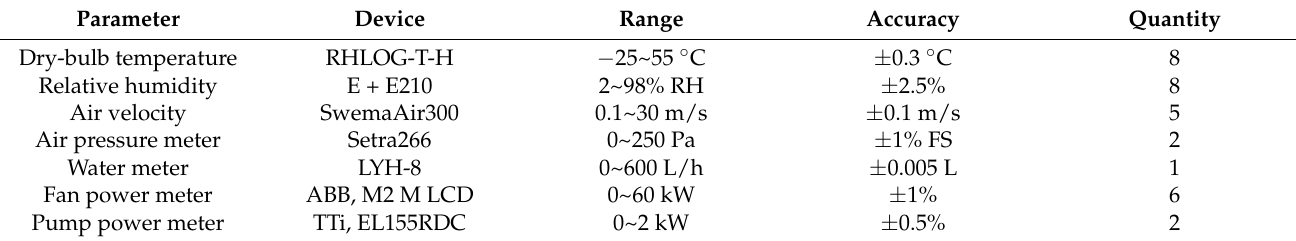
Table 1. Specifications of various measuring